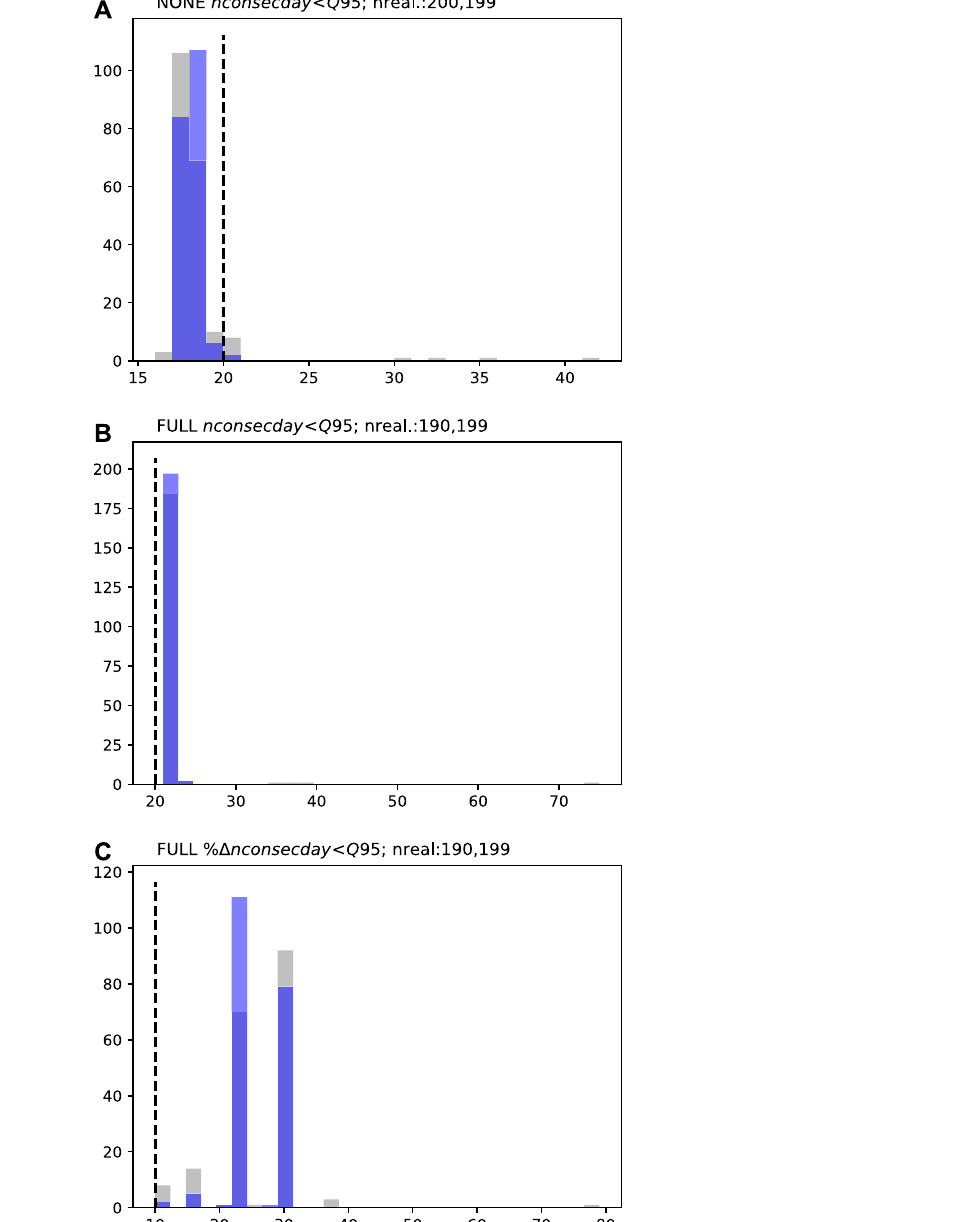
Frontiers in Earth Science |